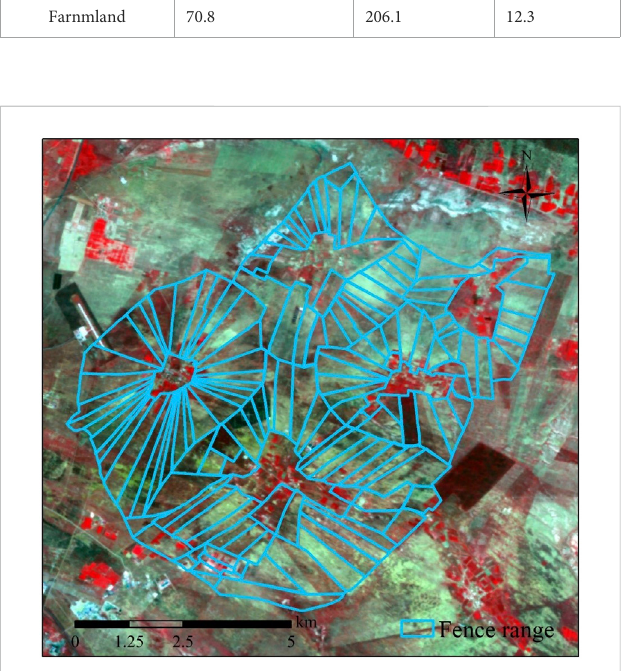
FIGURE 2 Division ofgrazing lands with fences offarmersinWanjigouVillage.